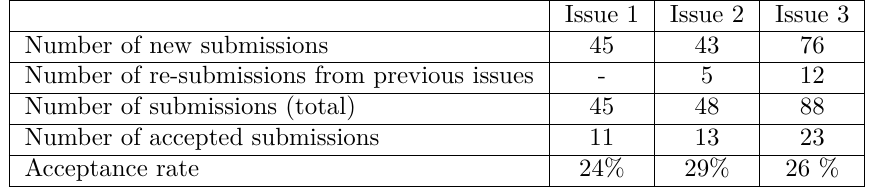
Table 1: Submission statistics of TCHES Volume